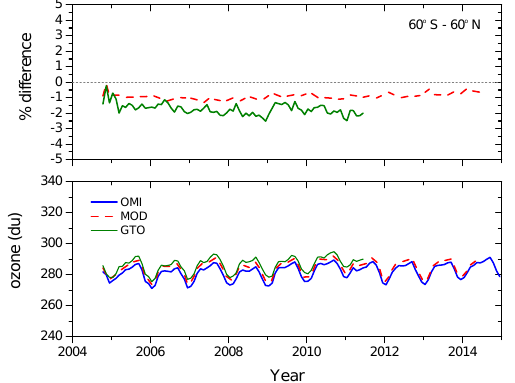
Figure 8. The MOD (merged ozone data) based on SBUV/2 instru- ments and the GTO (GOME type Total Ozone) merged ozone based on GOME instruments and SCIAMACHY are compared with